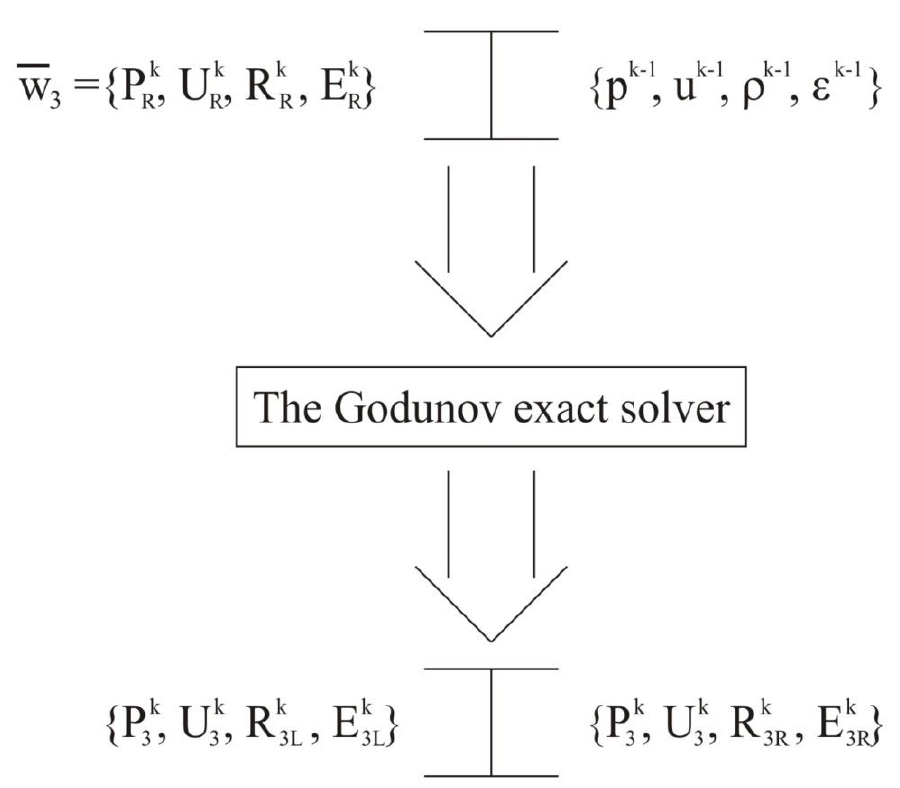
Figure A2. The first Riemann